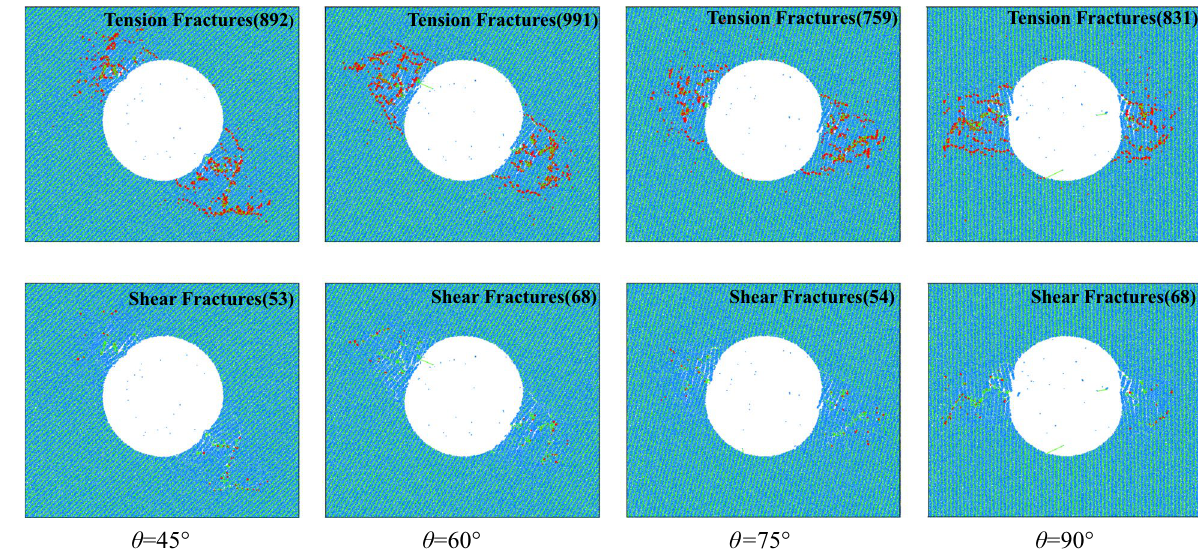
Fig. 23 Failure results of different joint inclination angles (for σ